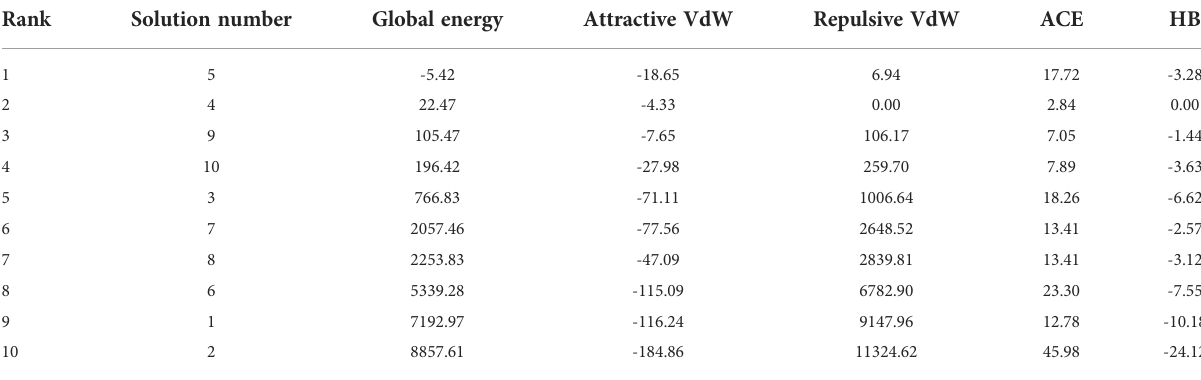
TABLE 4 Docking score of re fi ne complexes of TLR-8 and vaccine.